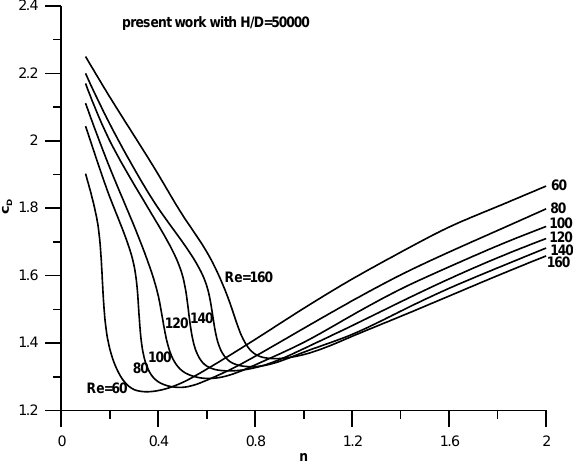
Figure 8. Values of the drag coefficient for different Reynolds numbers for shear-thinning and shear-thickening fluids in an unconfined field.